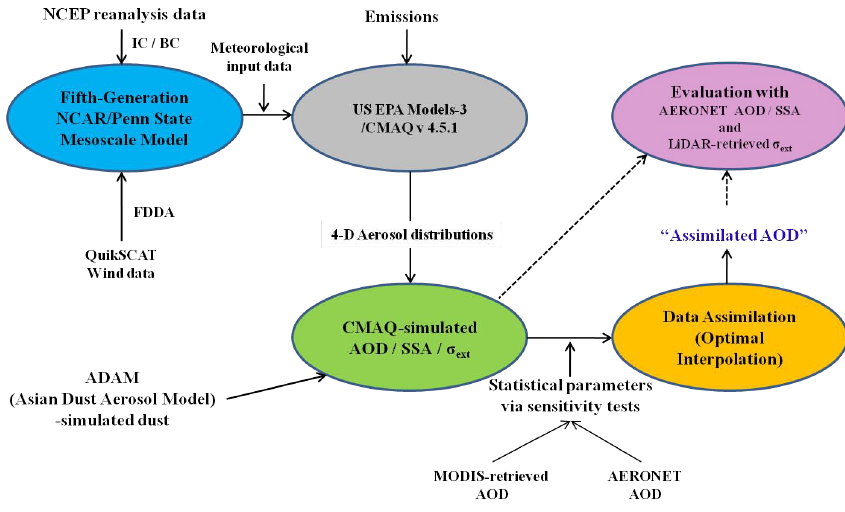
Fig. 1. Flow diagram of the procedures of this study, including: (1) meteorological modeling, (2) US EPA Models-3/CMAQ v4.5.1 modeling, and (3) data assimilations of wind data and the optical properties of